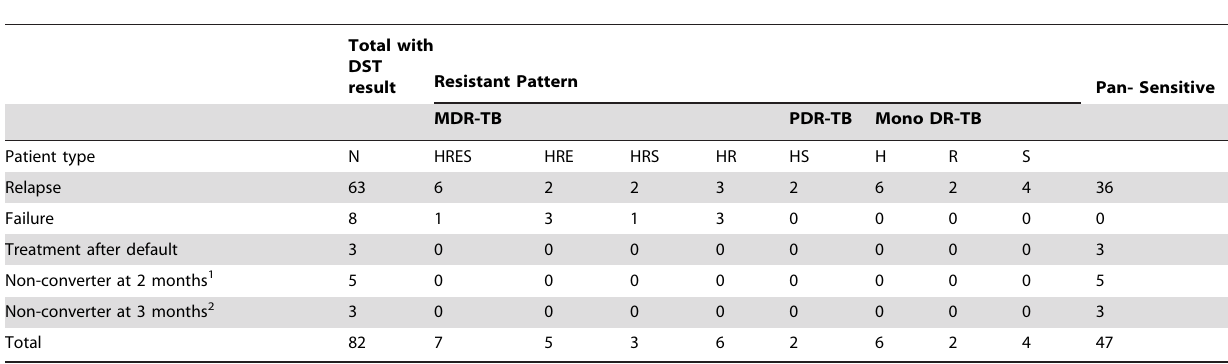
Table 2. Drug resistance pattern among different types of presumptive MDR-TB, Cambodia, 2011.